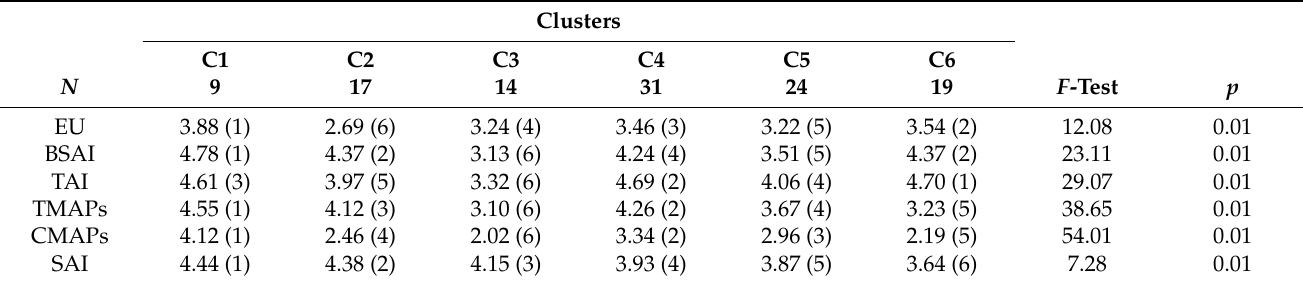
Table 5. Mean scores of variables within clusters (ranking of variables across clusters).